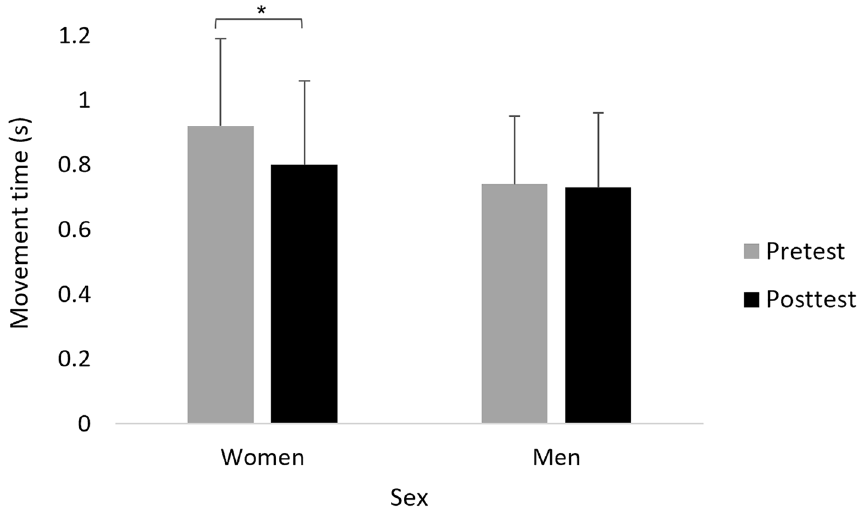
Figure 5. Mean movement time (s) of reaching movements in women and men in pretest and posttest, across stimulation groups (collapse across stimulation groups is presented because the interaction Time × Sex × Group was not significant). Error bars show standard deviation. Asterisks denote a significant difference.